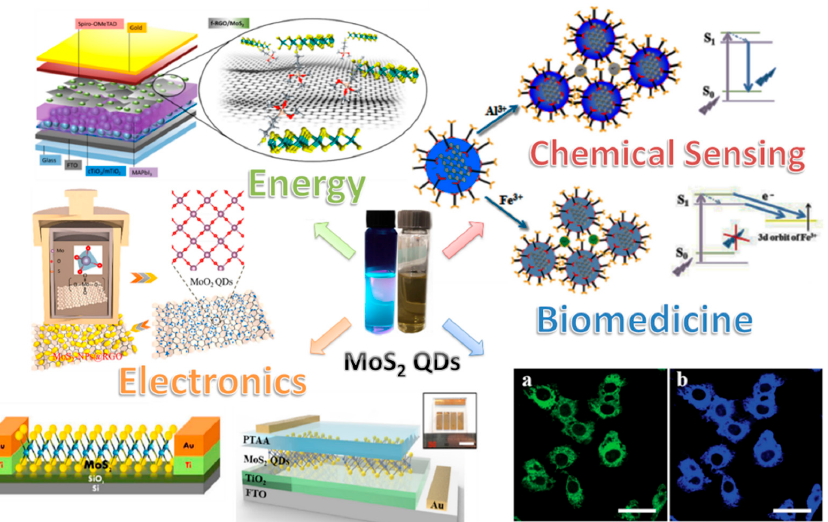
Figure 13. Applications of MoS 2 quantum dots. Exterior images reproduced with permission from [9,39,43,68,82,83]. Copyright: American Chemical Society; Elsevier Ltd.; WILEY-VCH Verlag GmbH & Co. KGaA, Weinheim.